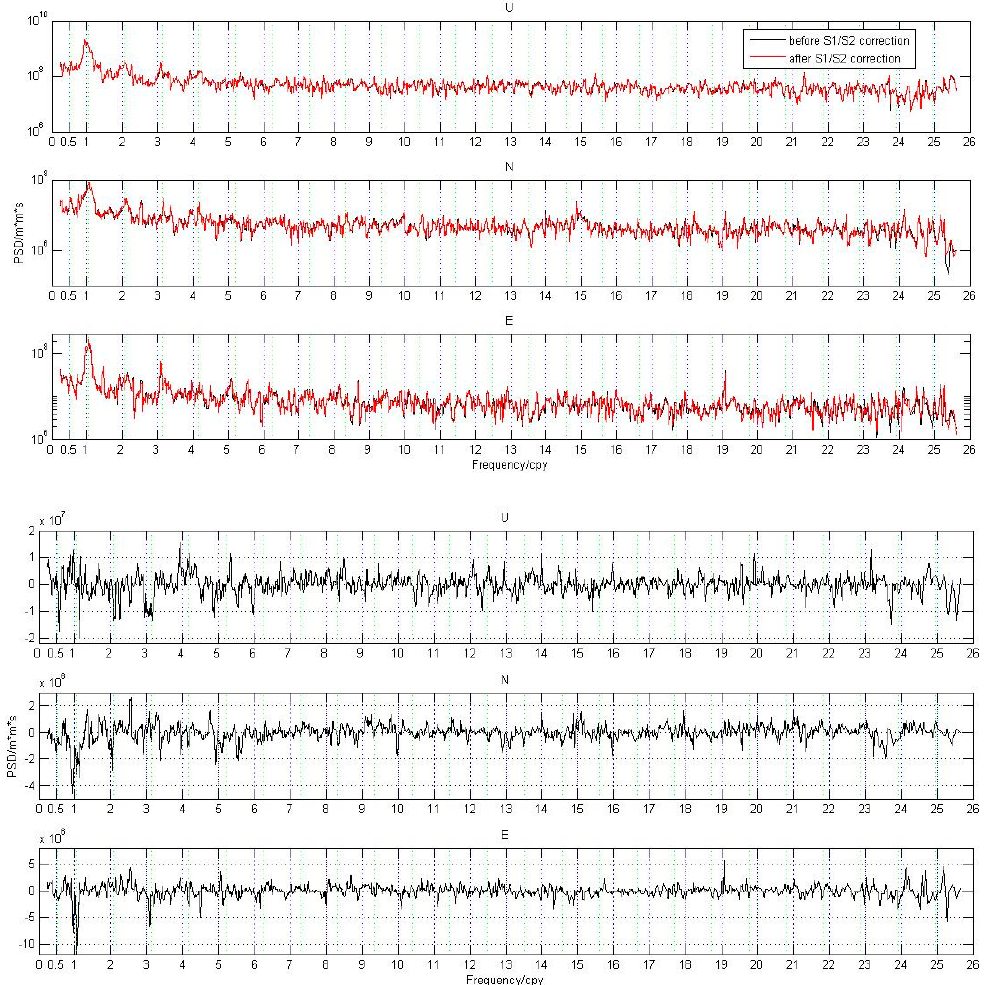
Figure 8. ( Top ) The global stacking PSD results for the filtered U, N, and E component before and after S1/S2 correction. ( Bottom ) The PSD difference caused by S1/S2 for each corresponding component. The vertical black and green dash lines in the figure denote the harmonics of the 1 cycle per year (cpy) and 1.04 cpy, respectively.